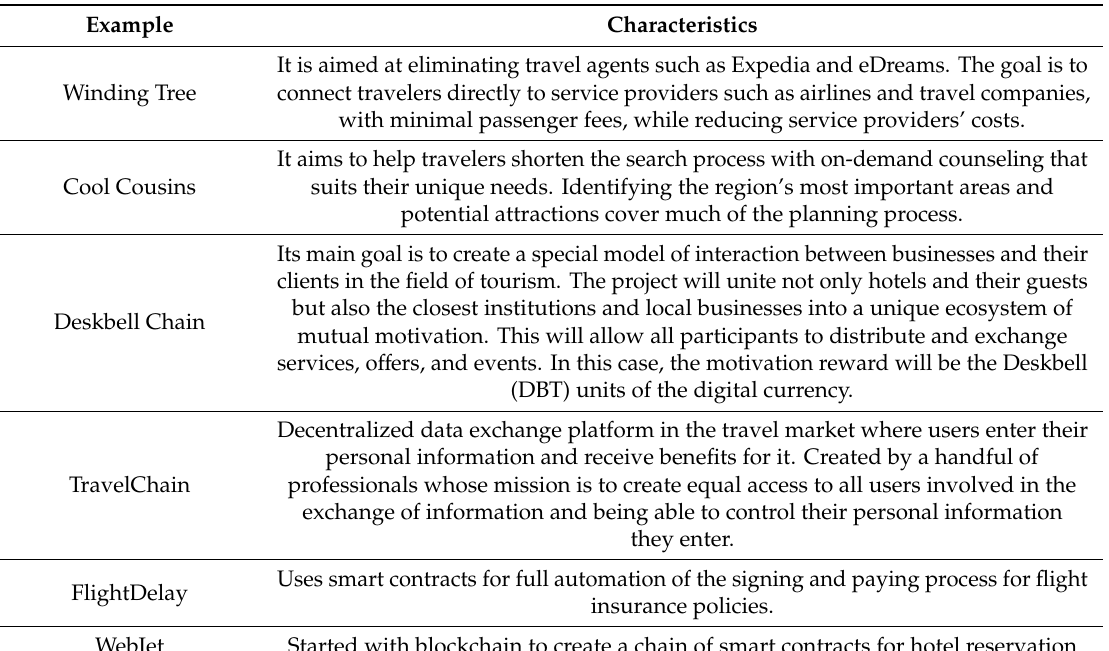
Table 4. Blockchain examples